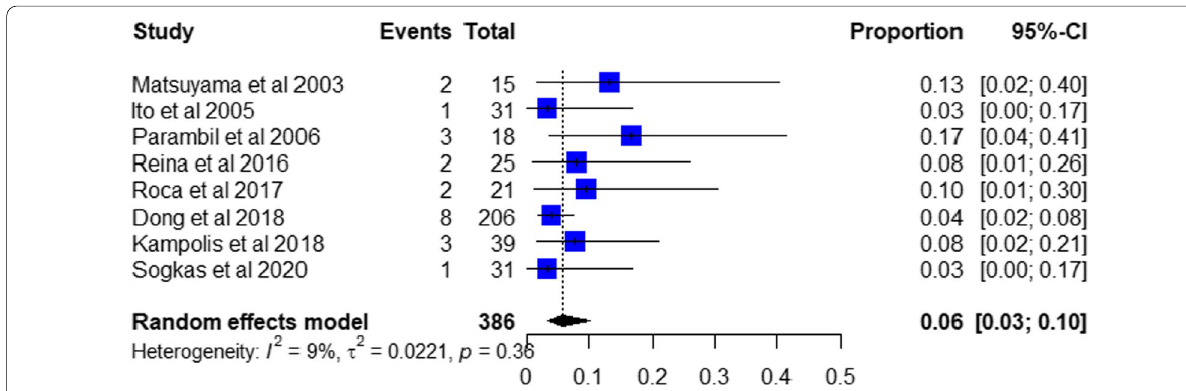
Fig. 7 Meta‑analysis of the Lymphocytic interstitial pneumonia in patients with Sjogren’s